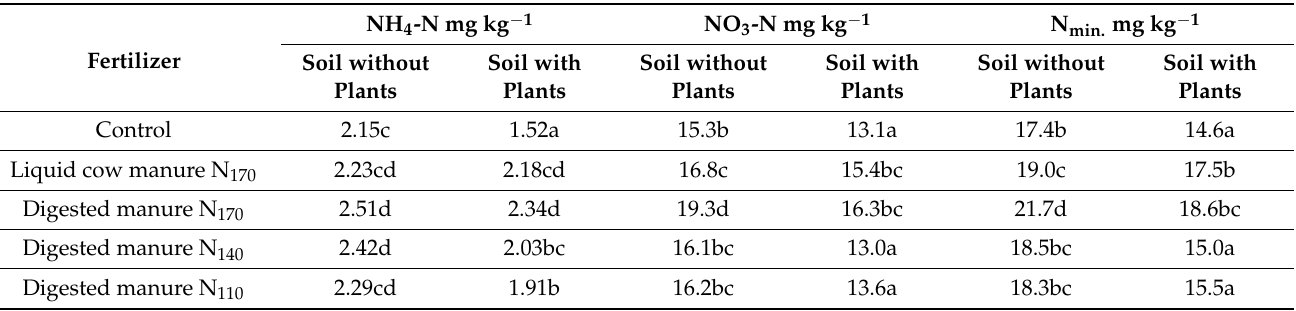
Table 2. The effect of digestate from liquid cow manure on changes in ammonium (NH 4 -N), nitrate (NO 3 -N) and mineral (N min. ) nitrogen in